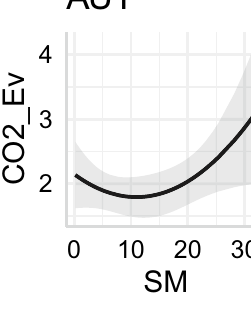
Figure 4. Effect of SM on CO2_Ev, H’, MB and CLPP in each of two seasons. Figures show predicted values based on the models listed in Table 5. In the two cases when the null model was selected (i.e., SM effect was not supported by the data), no figure is